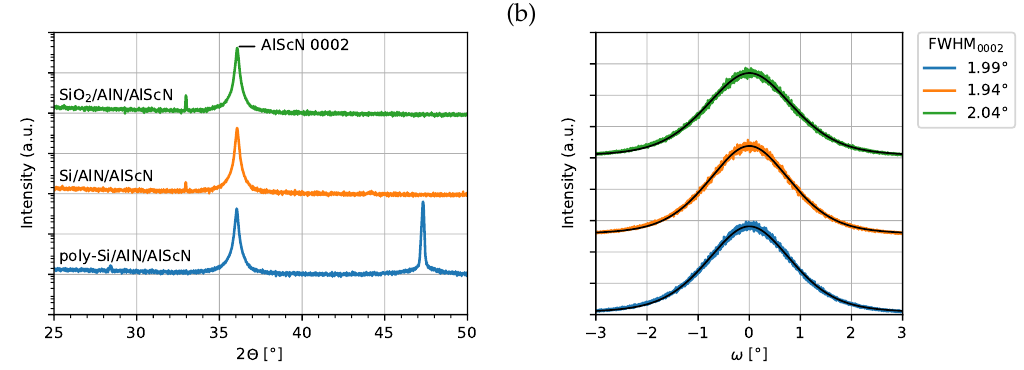
Figure 4. ( a ) θ -2 θ scans of 500nm AlScN grown on SiO 2 , Si and poly-Si substrates with the AlN seed layer; ( b ) Results of rocking curve measurements of AlScN 0002 reflections. The FWHM is determined by fitting a pseudo-Voight profile using the XRD fit module (Python-based open source tool for XRD peak fitting